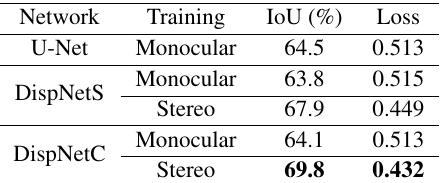
Table 2. Metrics comparison between monocular and stereo training on validation